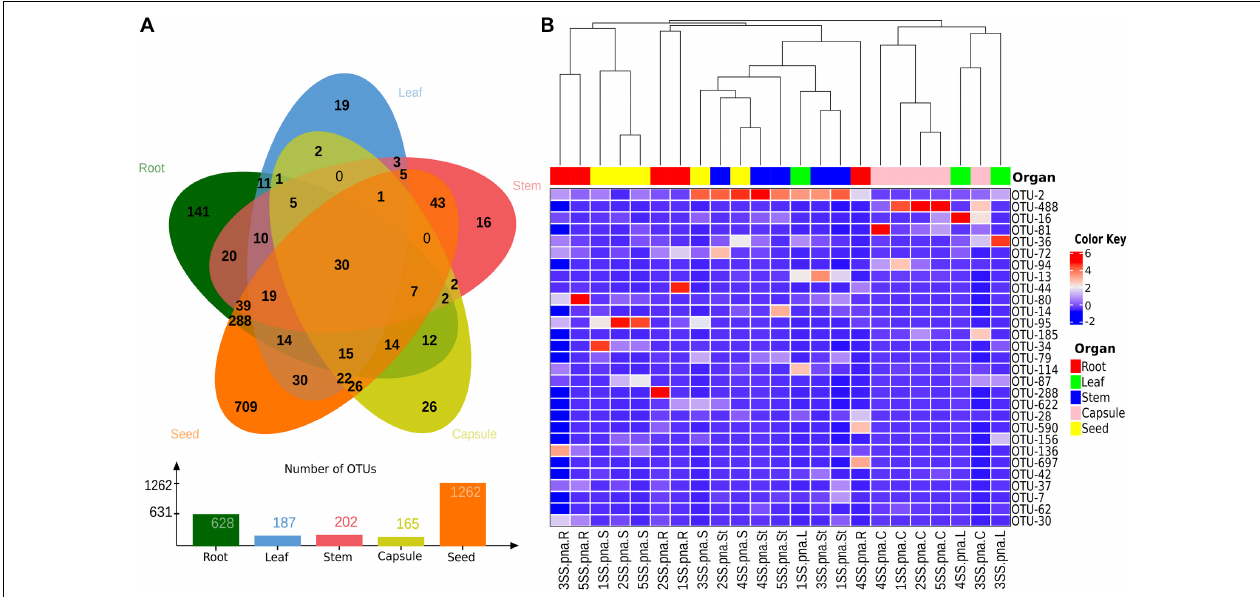
FIGURE 8 | Analyses of shared and major bacterial OTUs in the Spiranthes spiralis microbiota. (A) Venn diagram showing unique and shared OTUs between vegetative and reproductive organs (root, leaf, stem, capsule, seed). (B) Heatmap showing bacterial OTUs > 0.5% of the total sequences; samples were clustered by orchid organs (top row). Color Key from blue to red indicates increasing abundance in natural logarithm of counts, with OTUs along the Y-axis and samples along